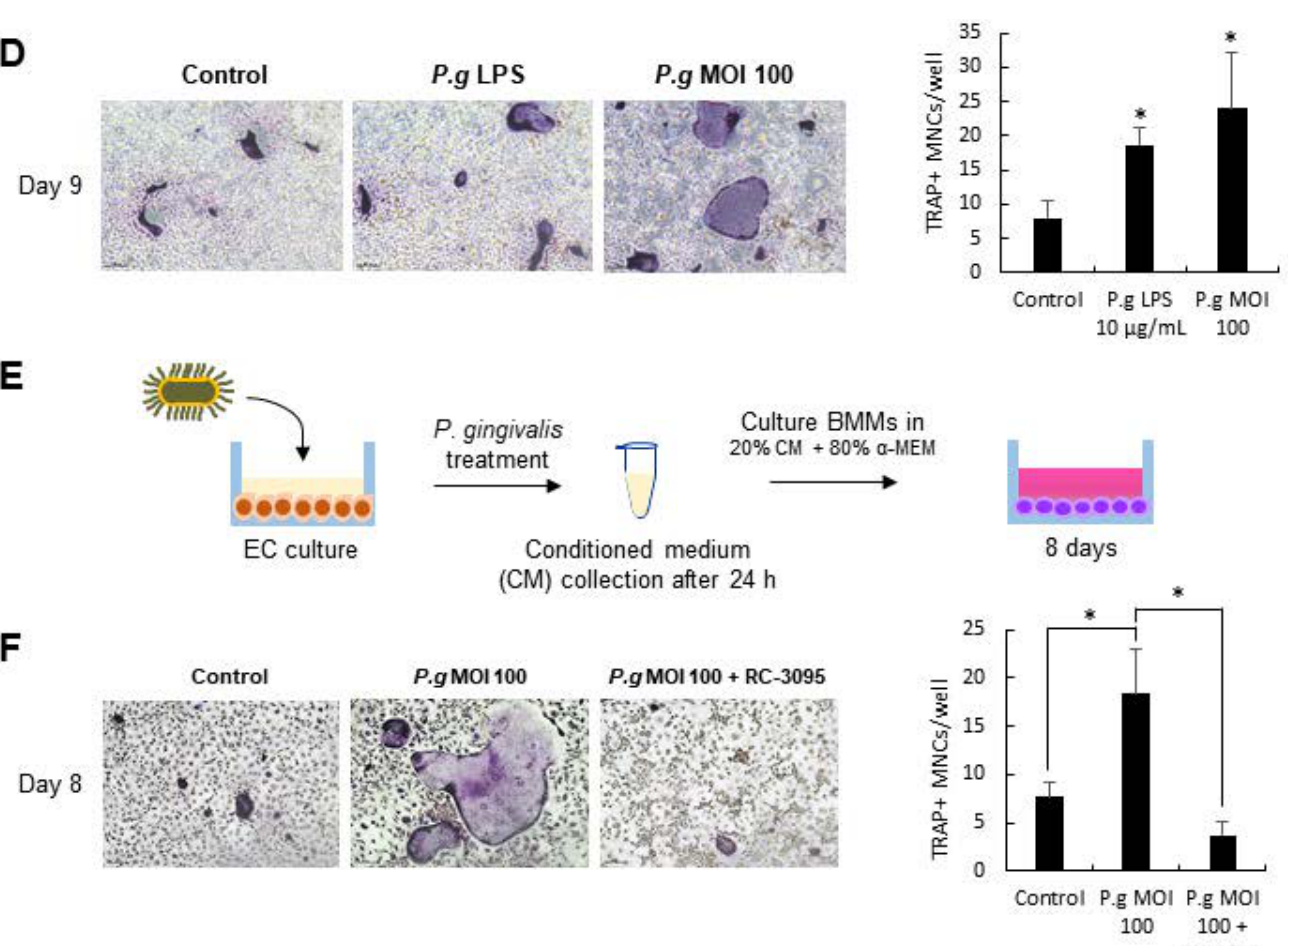
Figure 5. P . gingivalis -stimulated epithelial cells (ECs) can induce the differentiation of BMM. Grp and Grpr expressions in ( A ) mouse ECs and ( B ) HaCaTs; ( C ) Experimental procedure of coculture using ECs and BMMs in non-contact Transwell in the presence of 30 ng/mL M-CSF and 50 ng/mL RANKL to induce osteoclastogenesis; ( D ) TRAP+ osteoclast formation was promoted in cocultures with P. gingivalis -treated ECs; ( E ) Preparation of conditioned medium (CM) from P. gingivalis -treated (1 or 10 µ g/mL LPS and MOI 100) ECs; ( F ) BMMs cultured in 20% CM from P. gingivalis-inoculated ECs generated higher number of osteoclasts than the control. Scale bars, 100 µ m. Magnification, × 100. Quantitative data are presented as mean ± SD. * p < 0.05 and ** p < 0.01 by ANOVA test. Asterisk shows a significant difference from the control group unless indicated